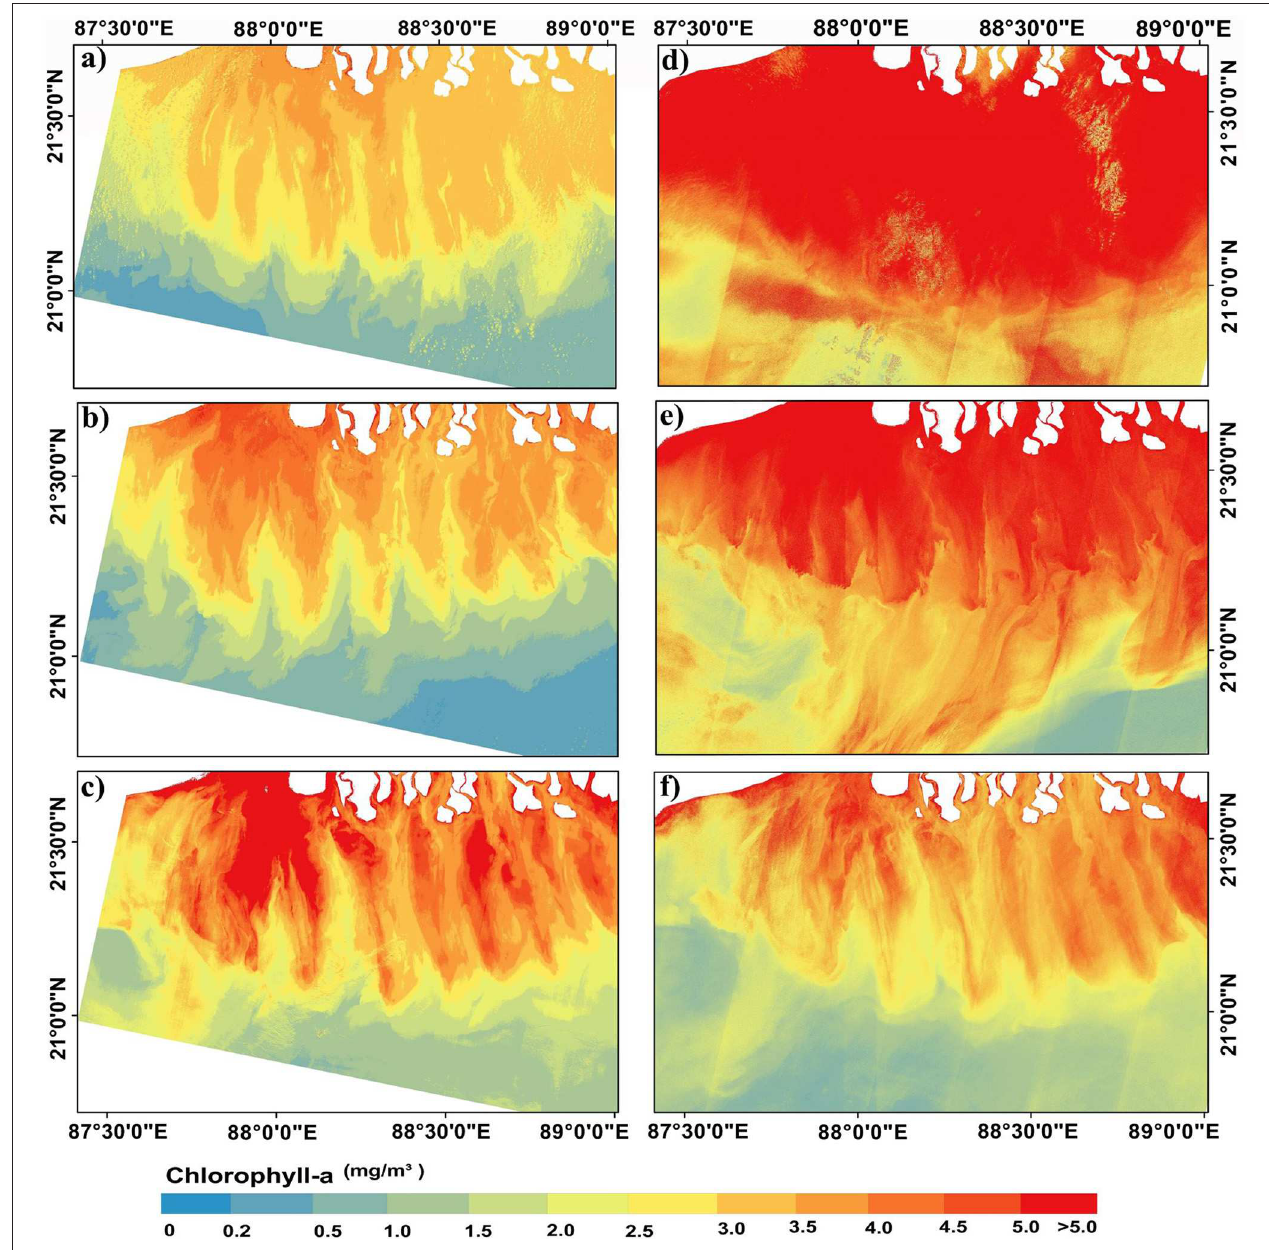
FIGURE 4 | Seasonal distribution of Chl- a during 2017 estimated from (a–c) Landsat-8 OLI, and (d–f) Sentinel-2